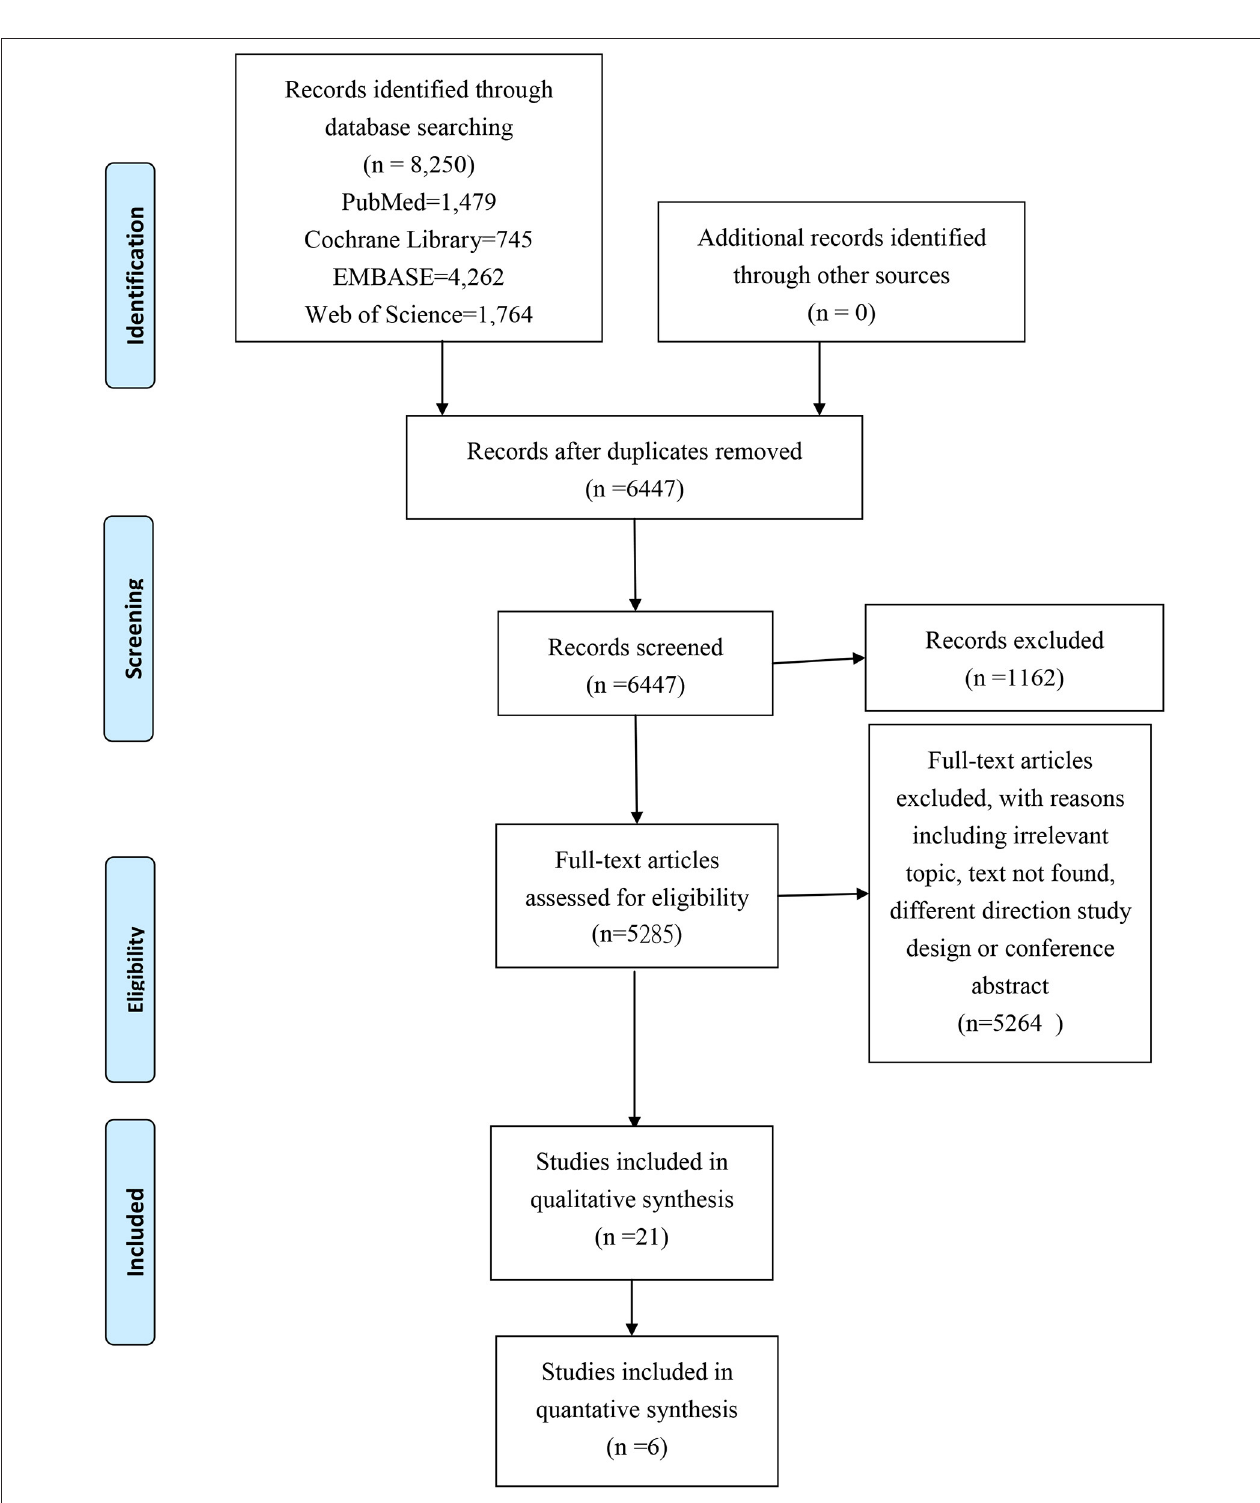
FIGURE 1 | Prisma study flow chart.